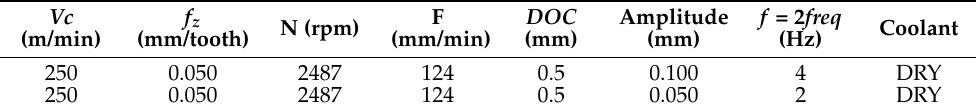
Table 3. LFAB boring specifications for different vibration conditions.